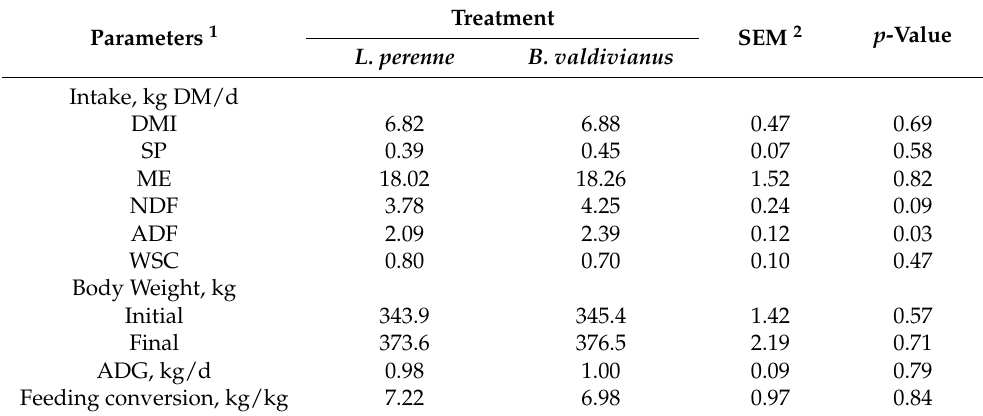
Table 2. Dry matter intake, body weight and average daily gain (ADG) of heifers grazing Bromus valdivianus and Lolium perenne .